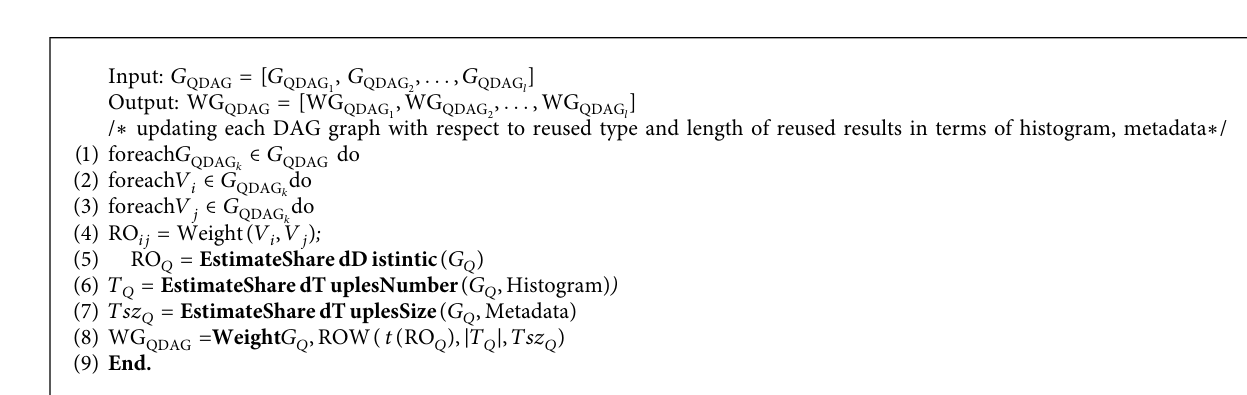
A LGORITHM 3: Update reused opportunity Definition 1. Reused-based Opportunities of Shared Pred- icates in Two-way Join (ROTWJ):